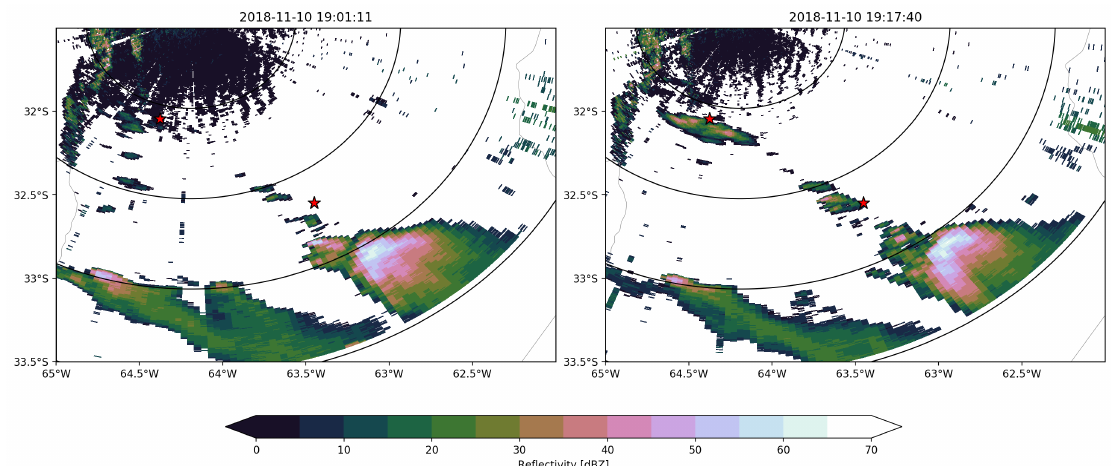
Figure 8. Radar reflectivity PPIs at 1.5 ◦ elevation from Argentinean Meteorological Radar 1 (RMA1) at 19:01 UTC ( left panel ) and 19:17 UTC ( right panel ). Parallax-corrected convective initiation estimated positions of OT1 and OT2 are indicated with red stars. Each black ring denotes 60 km range from the radar site in